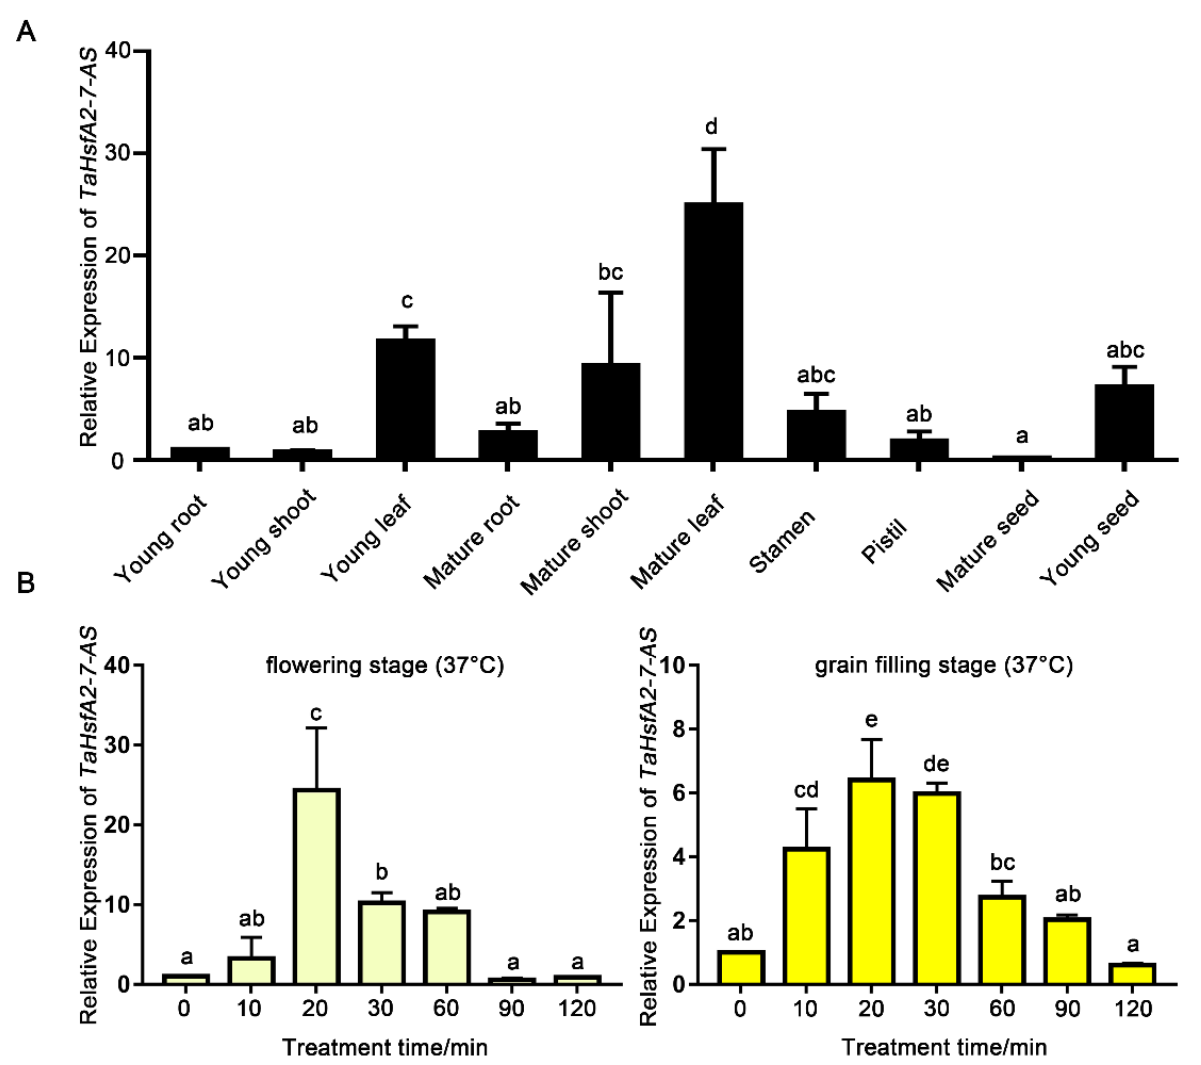
Figure 2. Expression analysis of TaHsfA2-7-AS. ( A ) Tissue-specific expression patterns of TaHsfA2- 7-AS . RNA samples were from tissue of wheat at different growth and development stages. The expression level in young root was set as “1”. ( B ) Expression levels of TaHsfA2-7-AS under heat stress at flowering and grain-filling stages. Wheat at flowering and growth stages was subjected to HS treatment (37 ◦ C), from which total RNA was extracted and analyzed by RT-qPCR. The control without HS was established in parallel. The wheat TaRP15 gene was used as an internal control. Bars are means ± standard deviation (SD) of three biological replicates. Different lowercase letters above the bars denote significant differences at the p < 0.05 level.